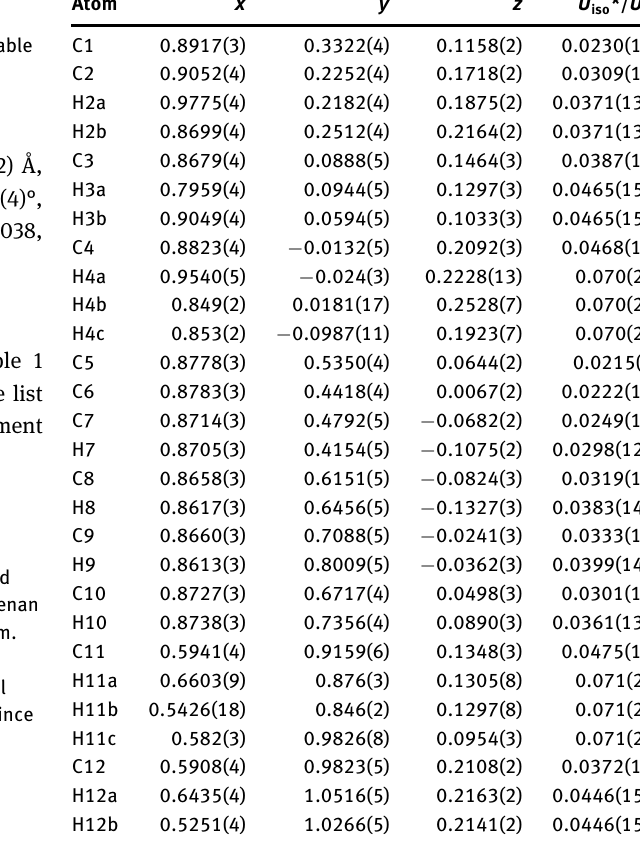
Table 2: Fractional atomic coordinates and isotropic or equivalent isotropic displacement parameters (Å 2